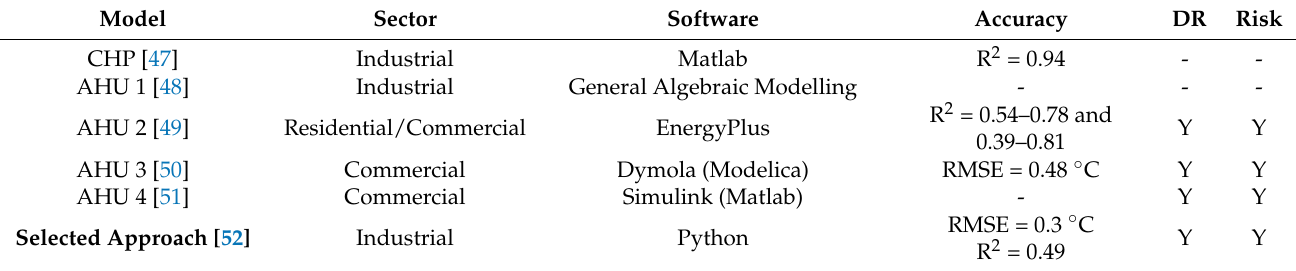
Table 1. Comparison of the modelling approaches considered to conduct further risk assessment and analysis, with the selected approach highlighted in